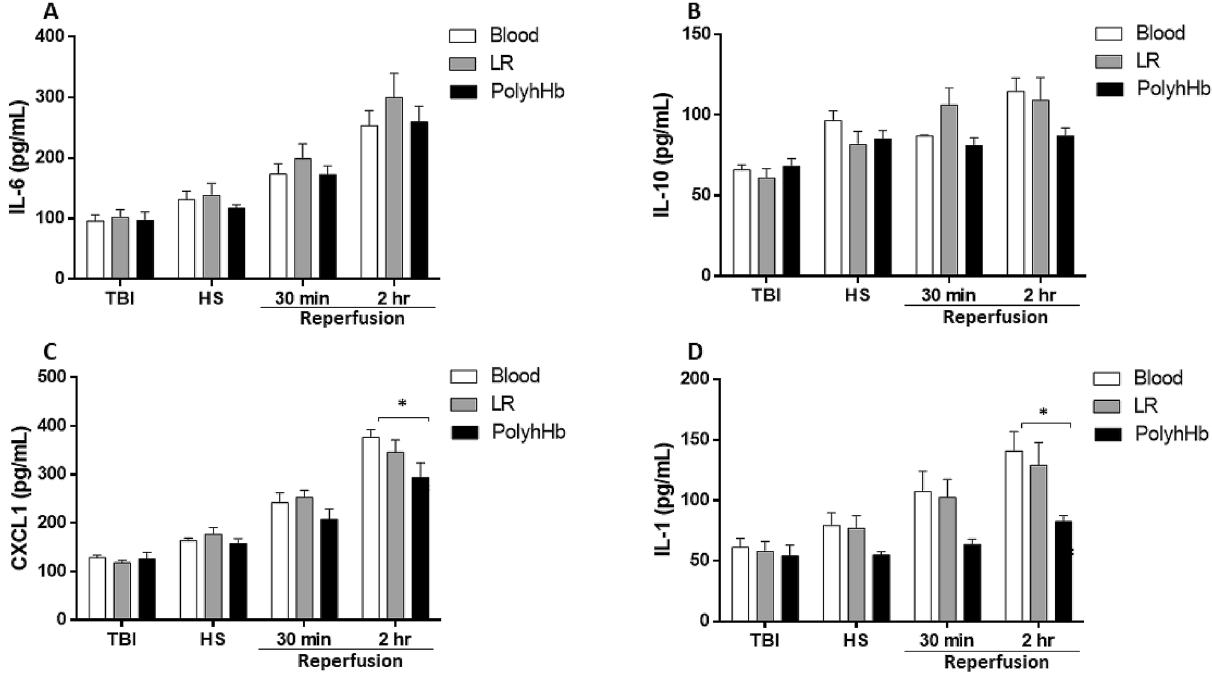
Figure 3. Plasma levels of inflammatory markers. ( A ) Interleukin (IL)-6 (IL-6); ( B ) IL-10; ( C ) Chemokine (CXCL1); ( D ) IL− 1. At BL (baseline); TBI (post traumatic brain injury); HS (hemorrhagic shock); 30 min into resuscitation; 2 h into resuscitation. LR Lactated Ringer’s solution. *p < 0.05. N = 5/group.